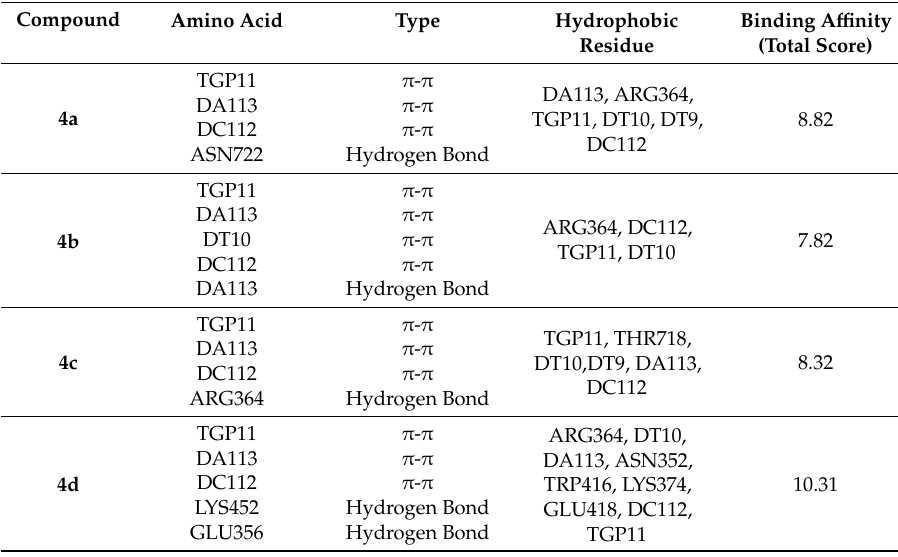
Table 4. Interactions between DNA-Topo I (from PDB ID 1T8I) and the compounds.